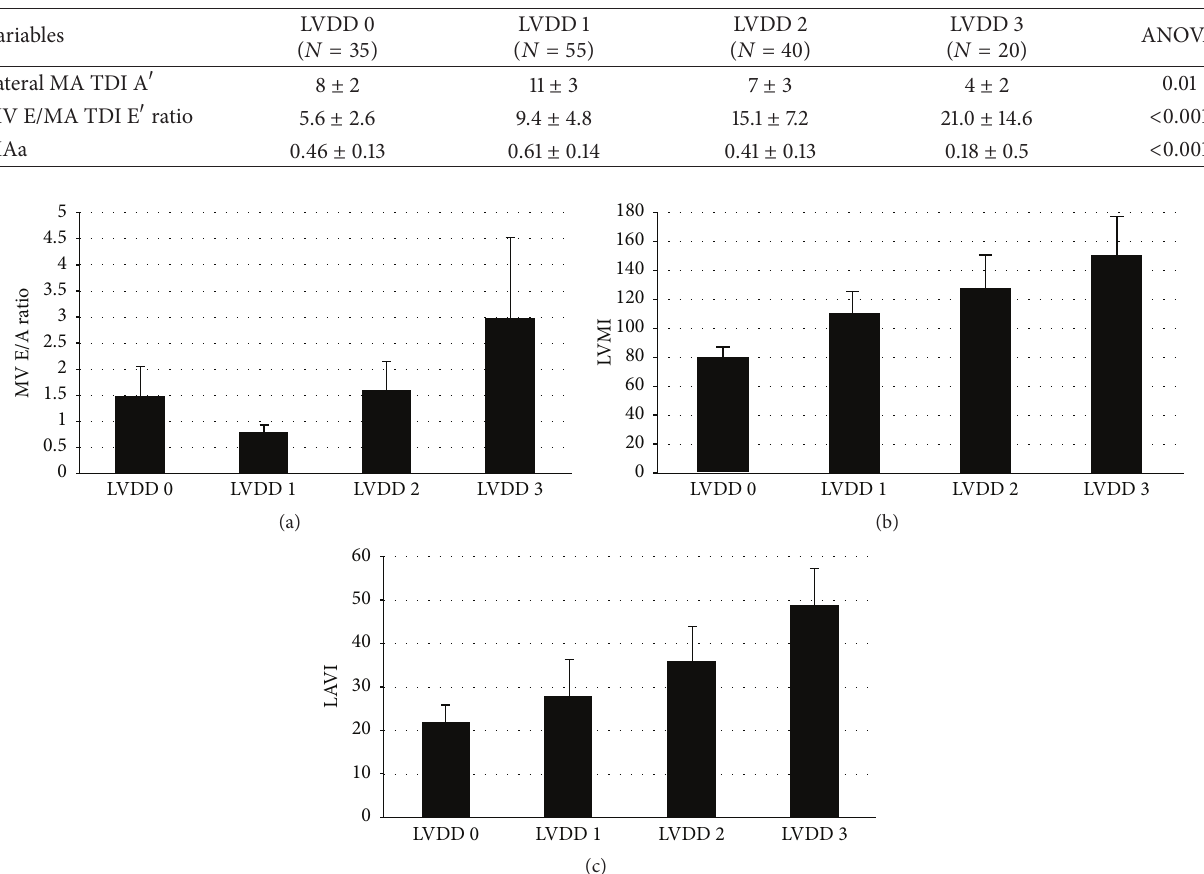
Table 2: Results for MAa, lateral MA TDI A 󸀠 , and MV/MA TDI E 󸀠 values for the study population according to LV diastolic function.